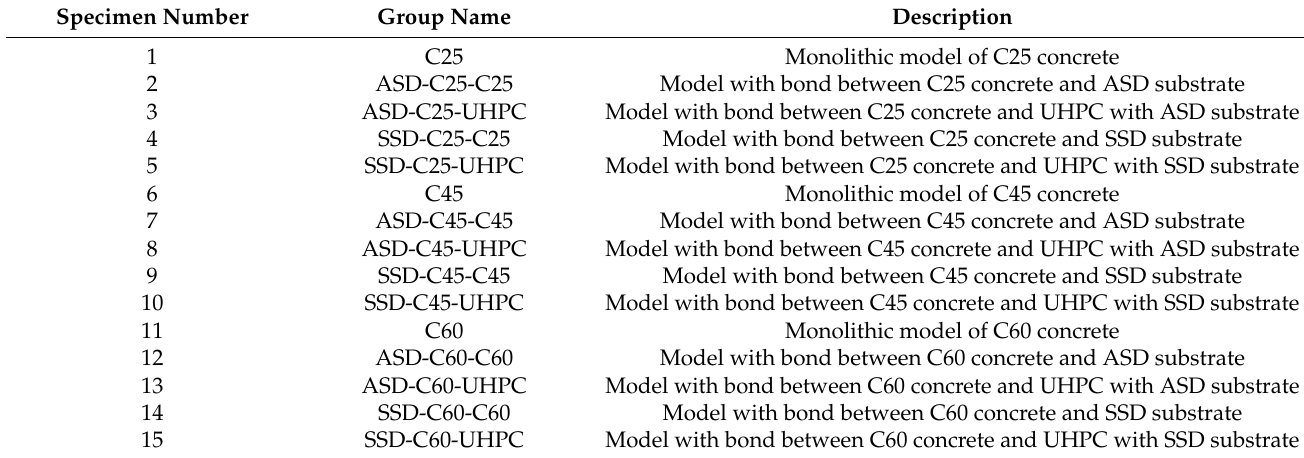
Table 2. Group nomenclature of studied